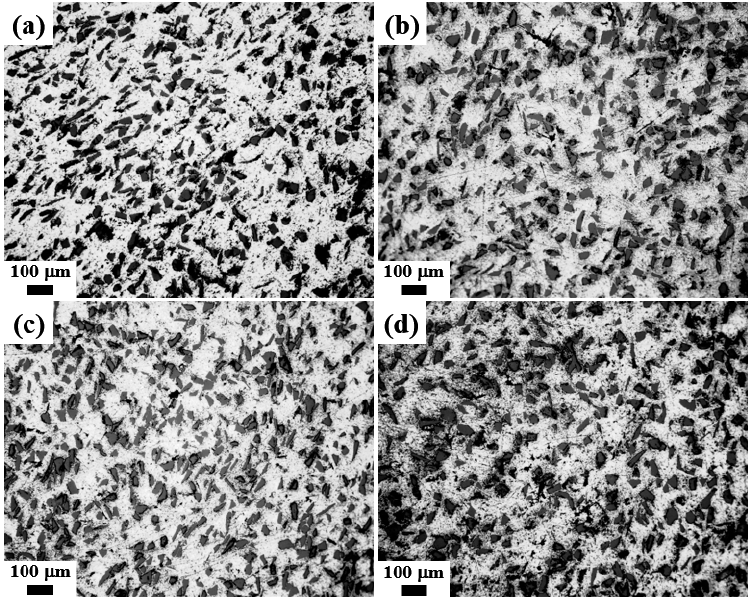
Figure 3. Optical micrographs of 20 vol% SiC (40 μ m)/Al 6061 composites produced by heating for 1 h at 640 °C under various flow rates of nitrogen gas: ( a ) 1 L/min, ( b ) 2 L/min, ( c ) 3 L/min, and ( d ) 4 L/min.